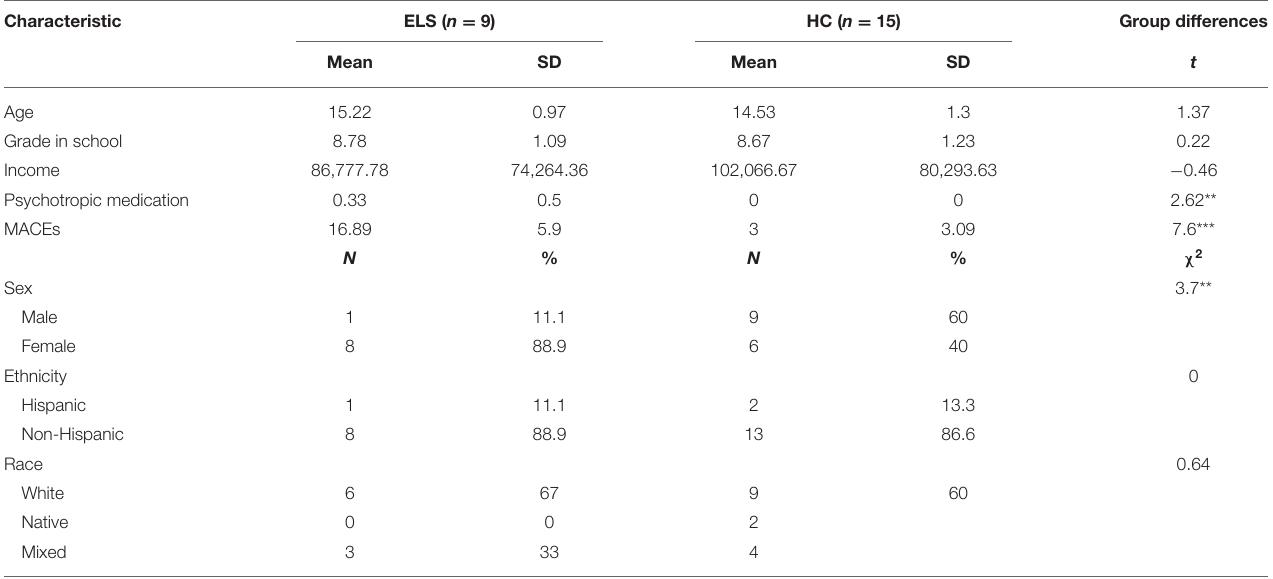
TABLE 1 | Sample demographic and maltreatment exposure